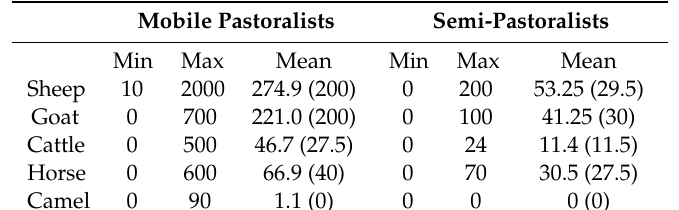
Table 1. Number of livestock owned by mobile pastoralists ( n = 82) and semi-pastoralists ( n = 13).